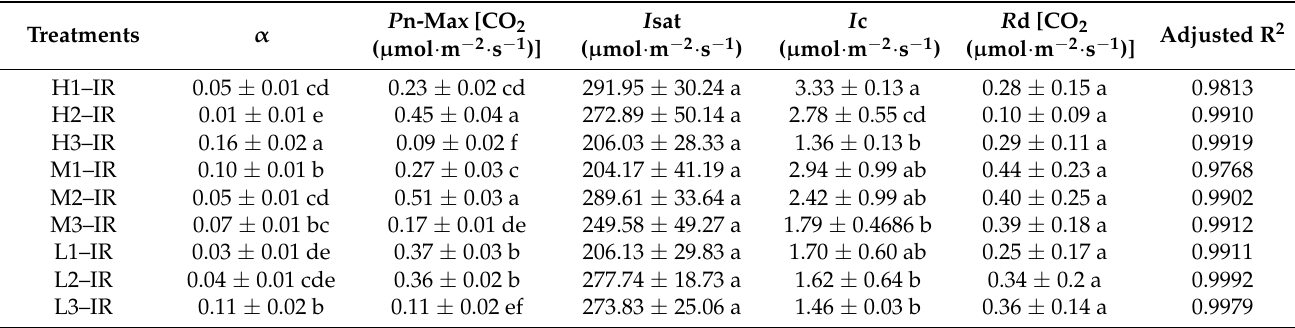
Table 2. Photosynthetic parameters of the leaves under different light conditions in the interior